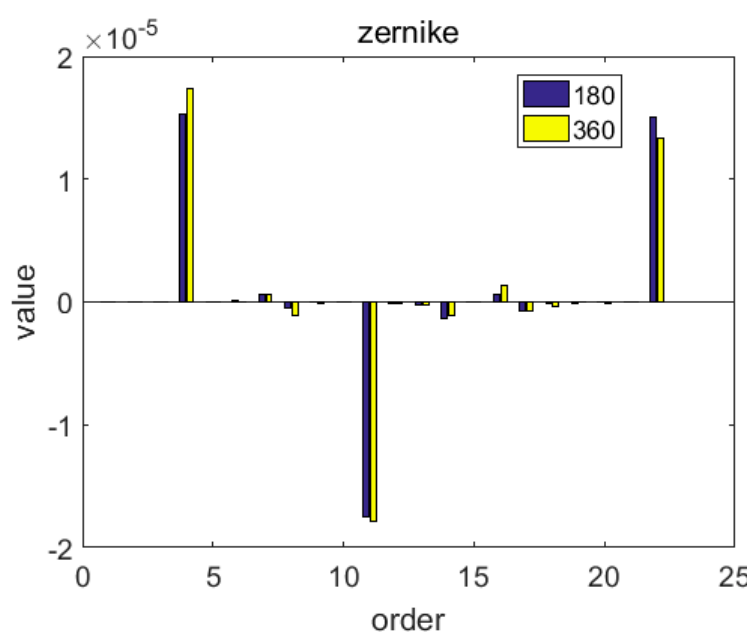
Figure 8. Zernike coe ffi cients of the wavefront aberrations for plans D and E.